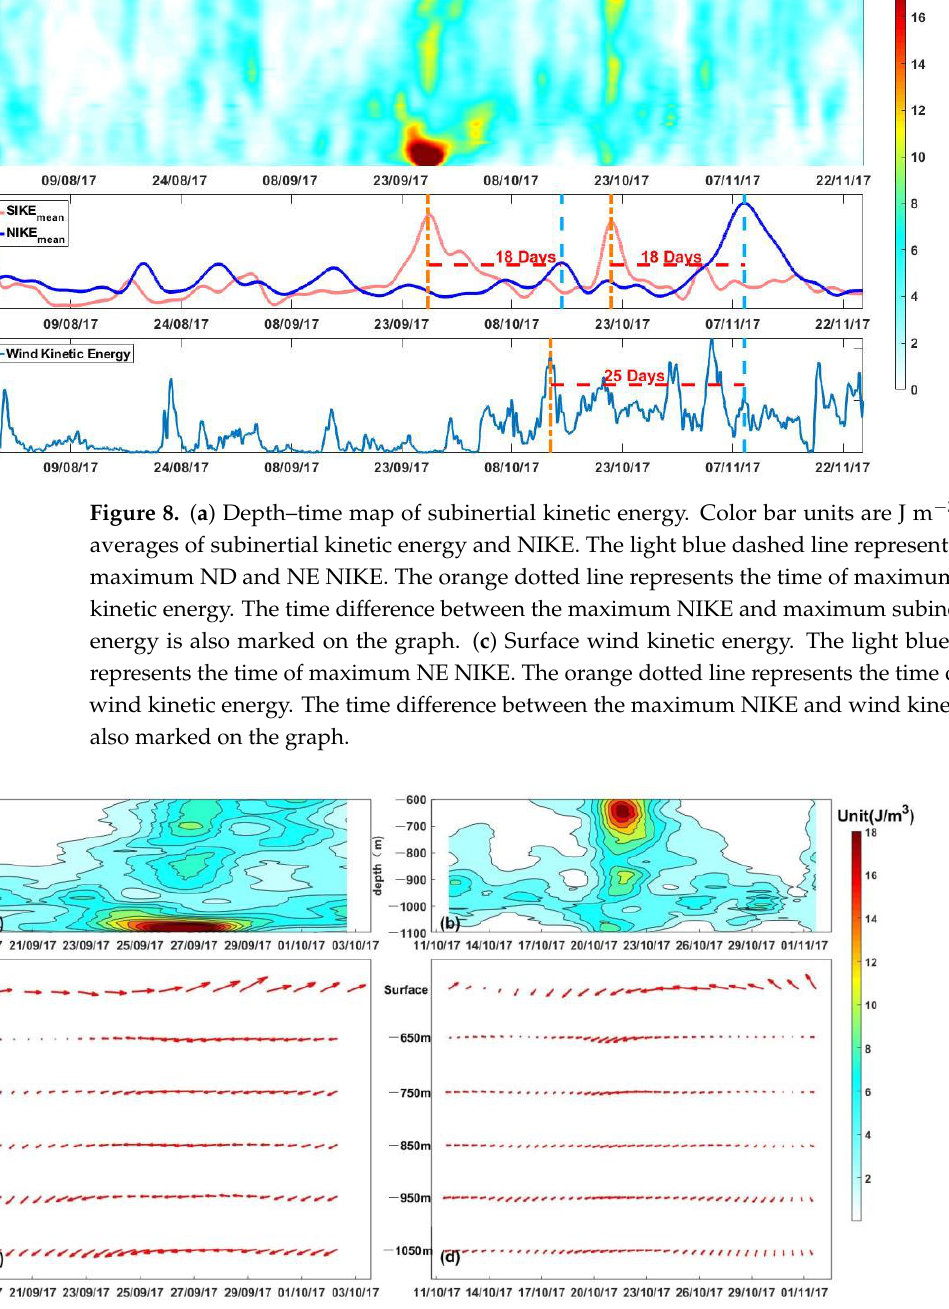
Figure 9. Spatiotemporal distribution of subinertial kinetic energy from 20 September to 3 October ( a ) and from 12 October to 2 November ( b ). Feather chart of subinertial velocity from 20 September to 3 October ( c ) and from 12 October to 2 November ( d ). Lander data are used for the 600–1100 m data. The surface data are illustrated by AVISO satellite surface flow field data at the Lander location.